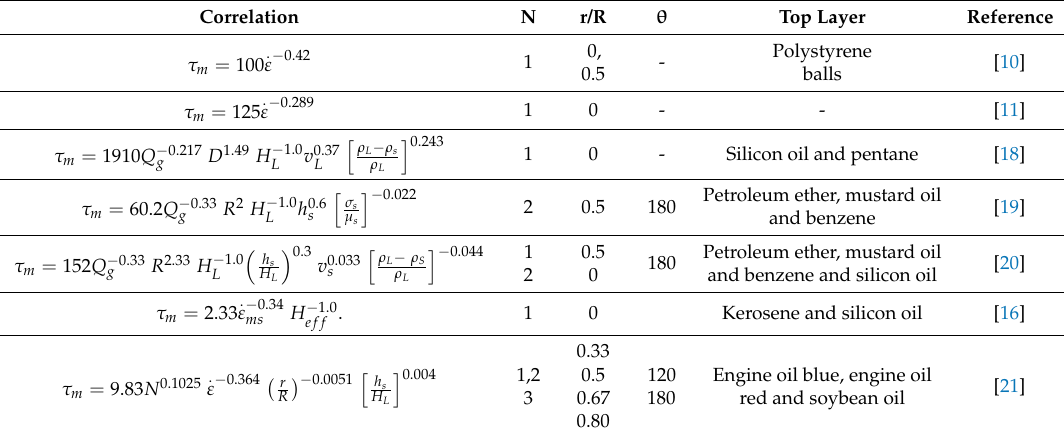
Table 2. Mixing time correlations for a denser phase with a lighter top layer